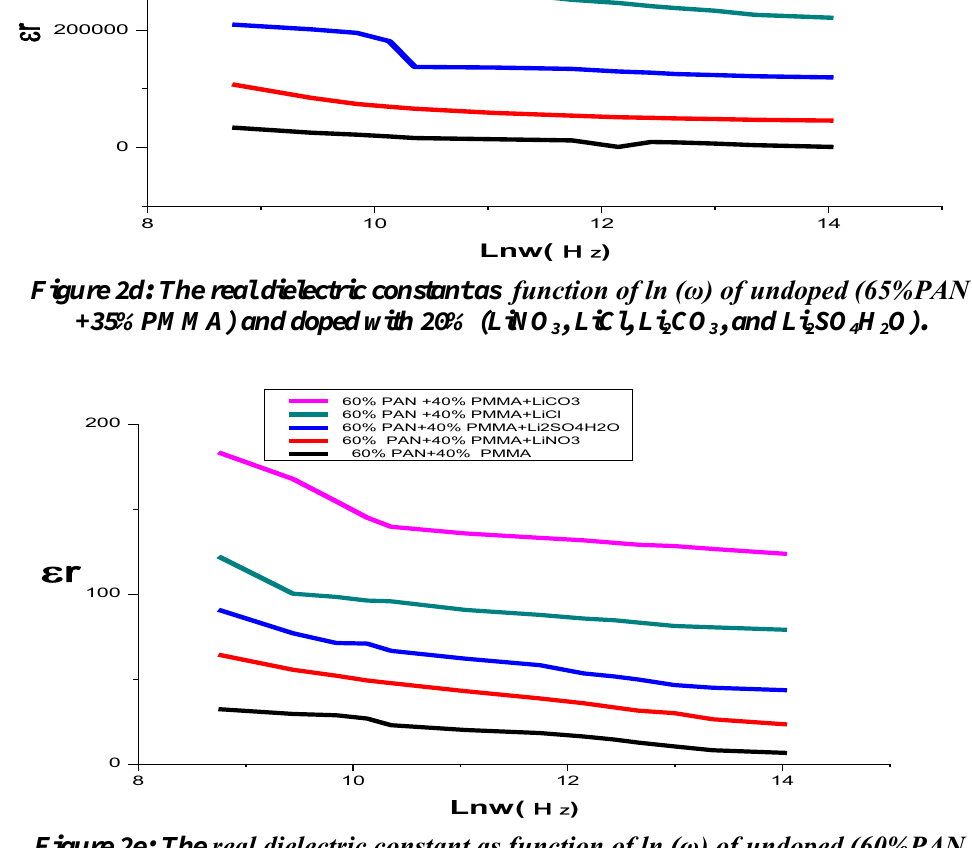
, LiCl, Li CO , and Li SO H 3 2 3 2 4 2